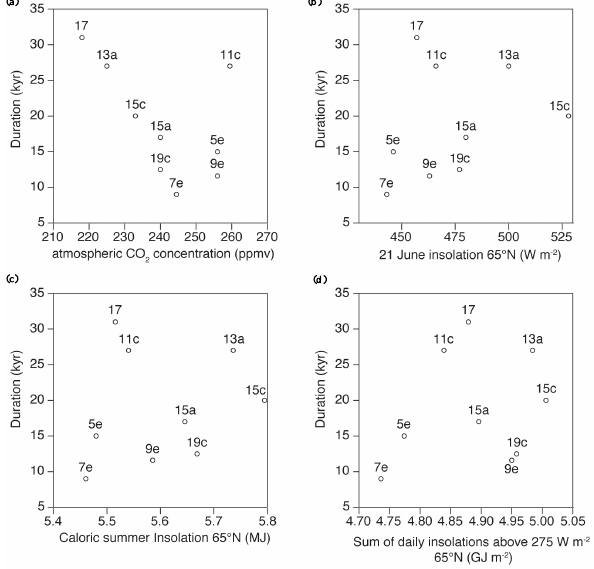
Fig. 10. Plot of atmospheric CO 2 and boreal summer insolation values at the time of glacial inception versus interglacial duration. (a) CO 2 concentration at inception versus duration; (b) daily mean insolation at the summer solstice (21 June) at 65 ◦ N (Laskar et al., 2004) at inception versus interglacial duration; (c) insolation at 65 ◦ N integrated over the caloric summer (the 180 days of highest insolation, assuming a 360-day year) (Milankovitch, 1941; Berger, 1978) at inception versus duration; (d) insolation at 65 ◦ N inte- grated over all days for which insolation exceeds 275Wm − 2 (Huy- bers, 2006) versus interglacial duration.